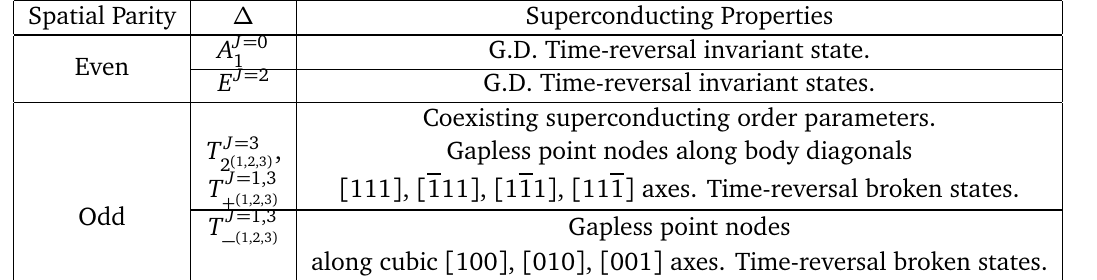
Table 1: Non-vanishing superconducting states resulting from electron-electron in- teractions induced by two-channel Kondo coupling. G.D. = Gapped dispersion with acquired k dependence from pairing potential. The corresponding order parameters are provided in Fig.